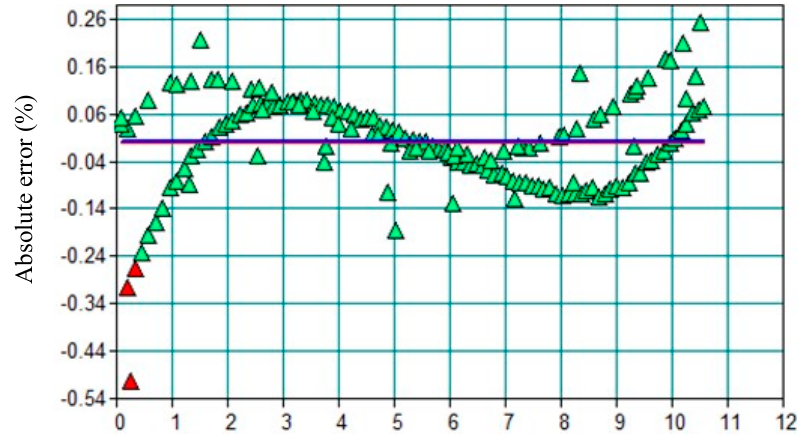
Figure 2. Absolute error vs weighed mass fraction of water for the NIR calibration.